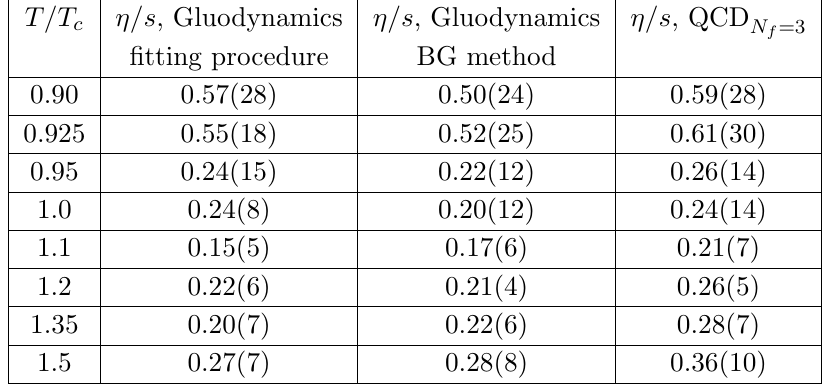
Table 2 . The ratio (cid:17)=s for various temperatures obtained by various methods. The results for gluodynamics obtained using the (cid:12)tting procedure are presented in the second column. The results for gluodynamics obtained within the BG method are presented in the third column. Estimation of the ratio (cid:17)=s for QCD with dynamical N f = 3 quarks are presented in the forth